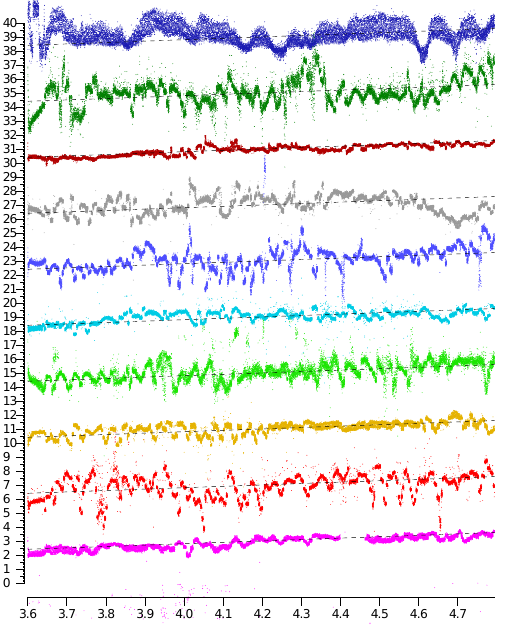
Figure 3. Sample measurements using ten responders in a range of positions (Top plot is for an access point operating in the 2.4 GHz band, the rest are in the 5 GHz band). Horizontal axis: actual position in meters. Vertical axis: reported distances in meters. (Note that the average slope of the plots is not equal to one, because the scales on the vertical axis and horizontal axes are different). (Individual plots are offset vertically to avoid